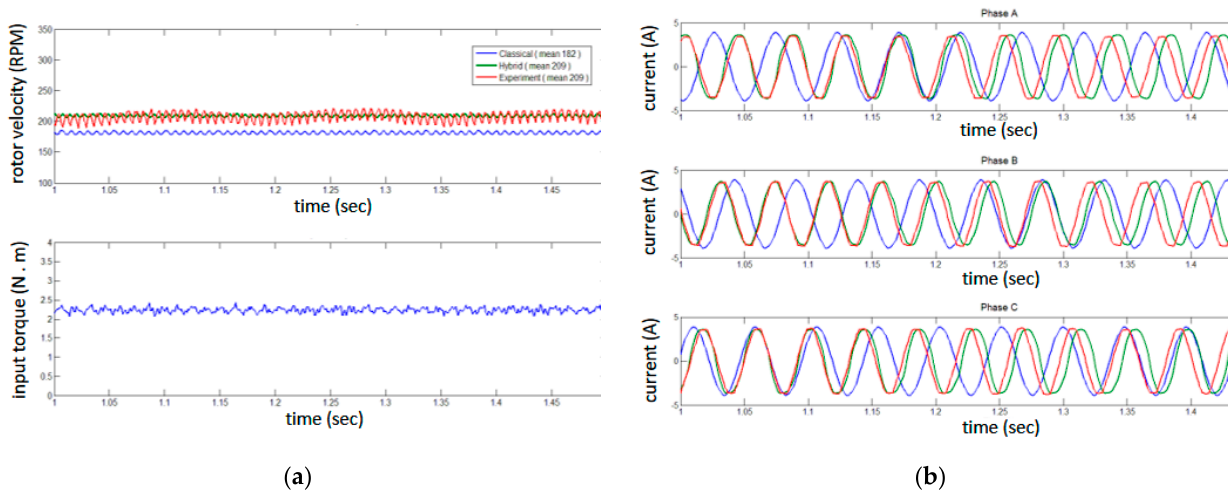
Figure 11. Low-speed steady state response, showing ( a ) the rotor velocity and input torque and ( b ) a comparison of the stator currents. The plots show a comparison of the classical model (blue trace), hybrid model (green) and experimental measurements (red).